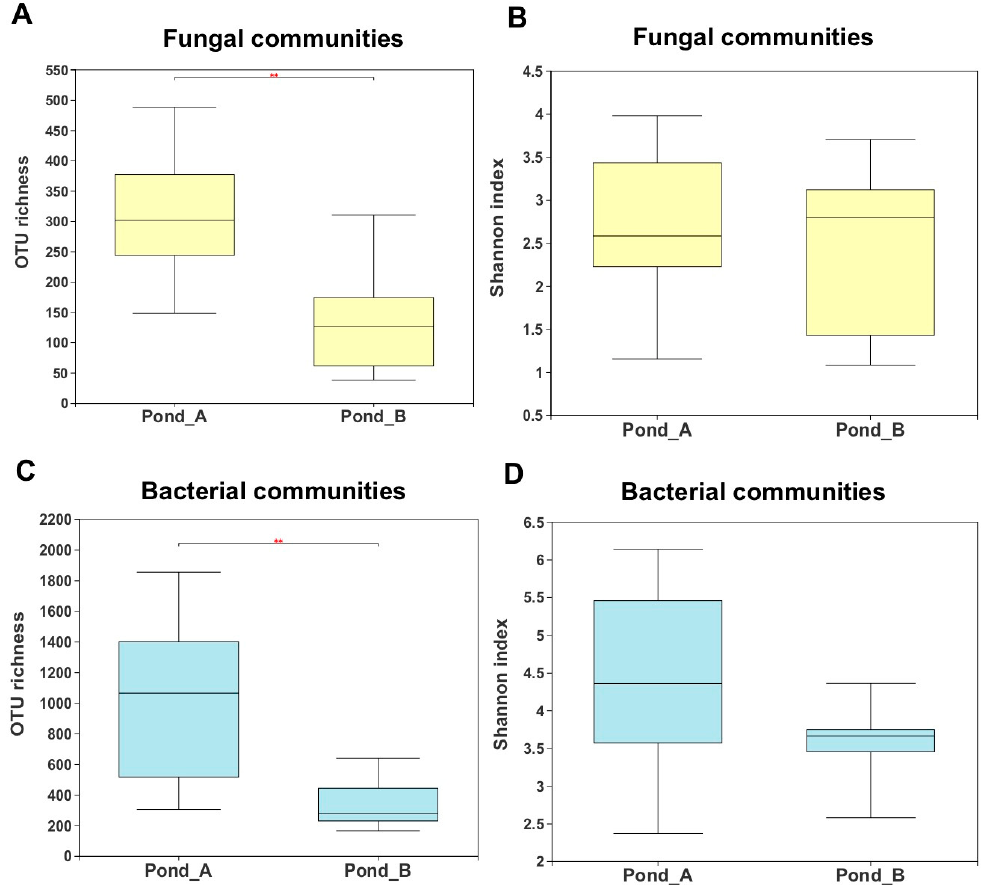
Figure 3. Sediment fungal and bacterial alpha diversity (OTU richness and Shannon index) in two ponds of the Julong hot springs. Difference between Pond A and Pond B as evaluated by a Wilcoxon rank-sum test is indicated as: ** p < 0.01. ( A ) Fungal OTU richness; ( B ) Fungal Shannon index; ( C ) Bacterial OTU richness; ( D ) Bacterial Shannon